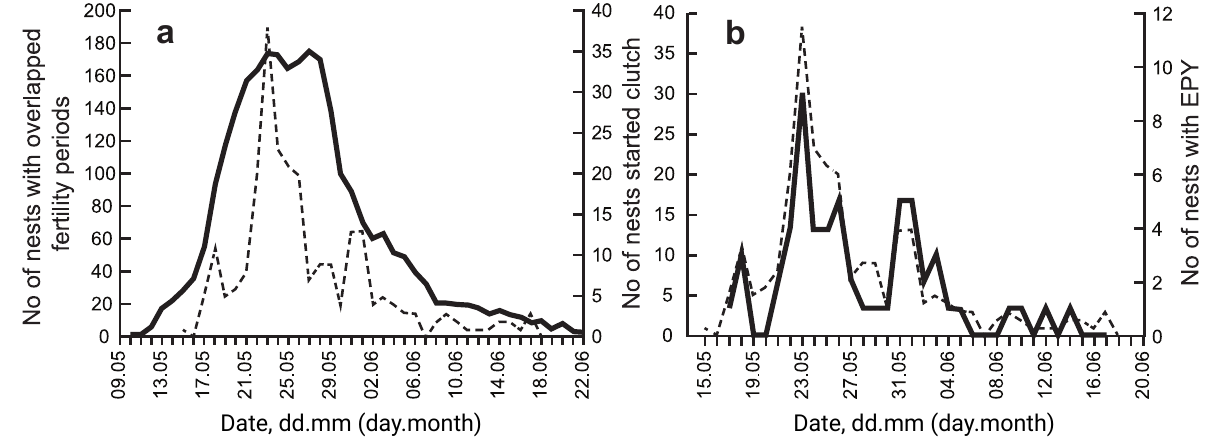
Figure 2. Clutch start dates, overlapping fertility periods ( a ) and number of nests with EPY ( b ). The dashed line on parts ( a , b ) is the number of nests that a clutch is started on the relevant date; the solid line on ( a ) is the number of nests whose female fertility periods overlap on the relevant date; the solid line on ( b ) is the number of nests with EPY on the respective date.